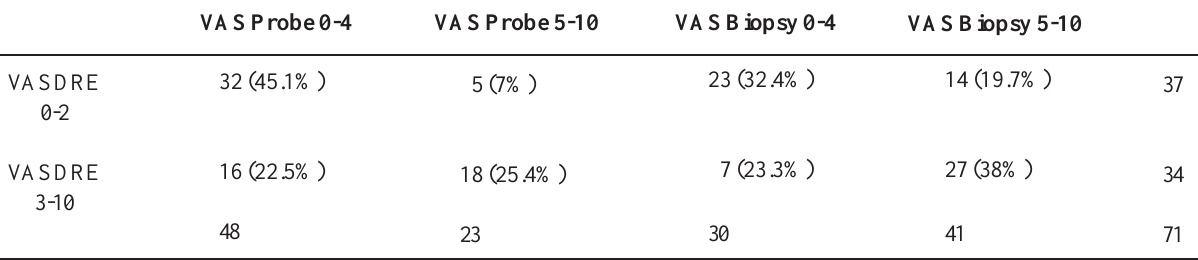
VAS = visual analogue scale; N% = percentage of the total of